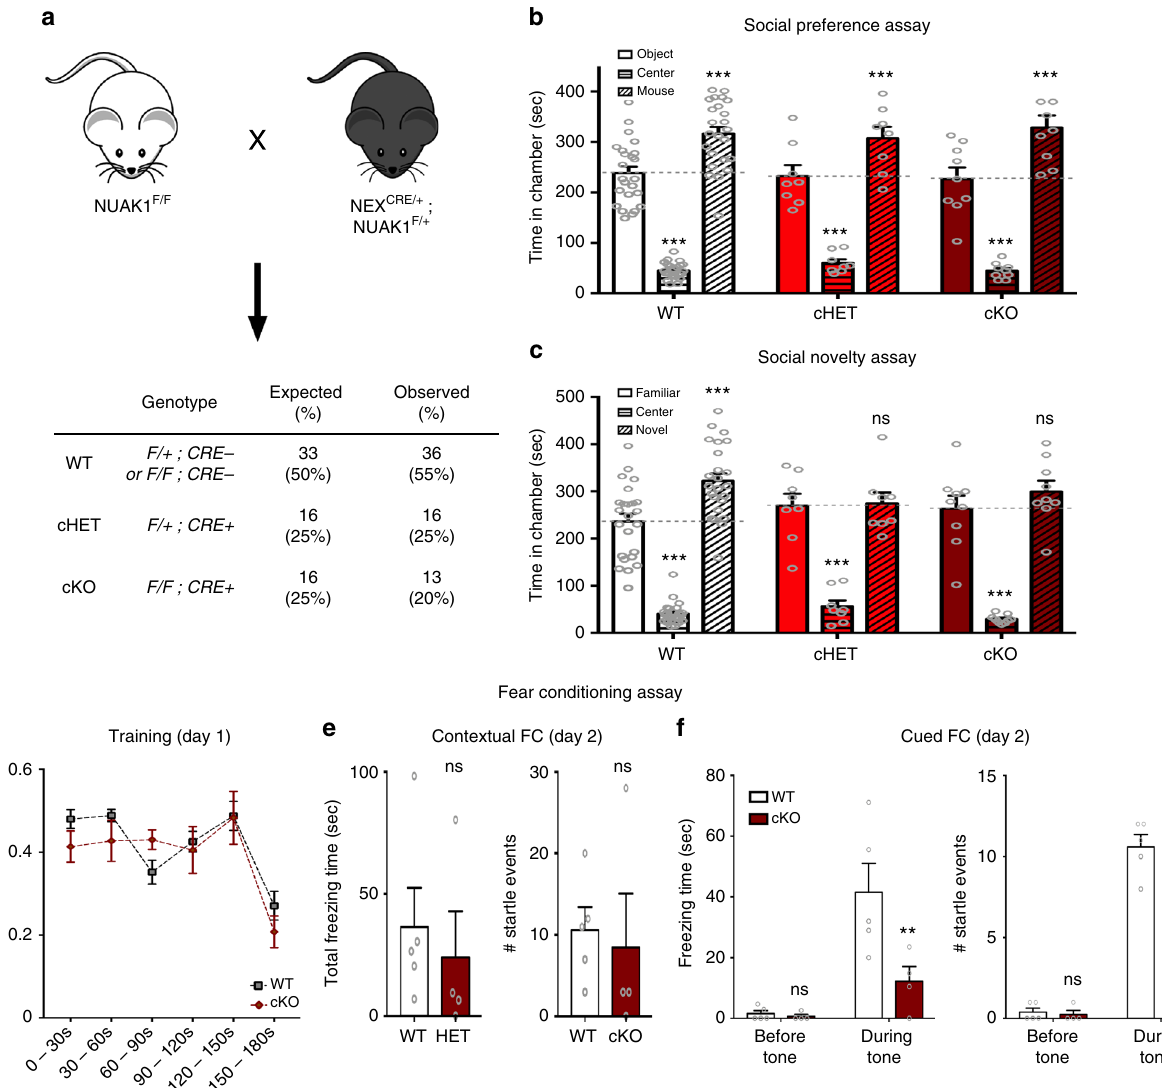
Fig. 6 Reduced preference for social novelty upon complete loss of NUAK1 in the cortex. a Breeding strategy for dorsal-telencephalon speci fi c inactivation of Nuak1 . Observed proportion of each genotype was matching the expected proportion following mendelian rule. b , c 3-chamber sociability and social novelty assay in NUAK1 cKO mice. Quanti fi cation of time spent in each chamber revealed a decreased preference for social novelty in cHET and cKO